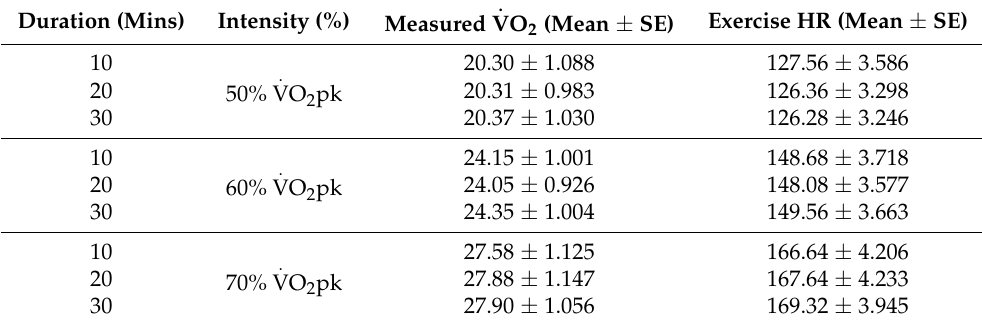
Table 2. Oxygen usage and heart rate (HR) responses at different intensity percentages and duration of exercise.